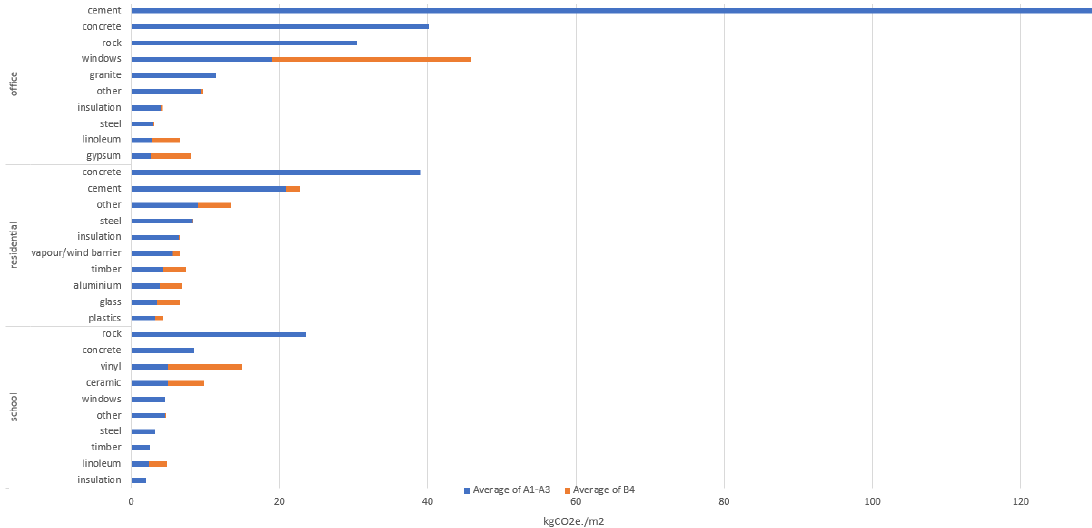
Figure 6. The ten material groups with the largest average contributions to production emissions per floor area for three typologies from the building element “Envelope, foundation, and structure.”